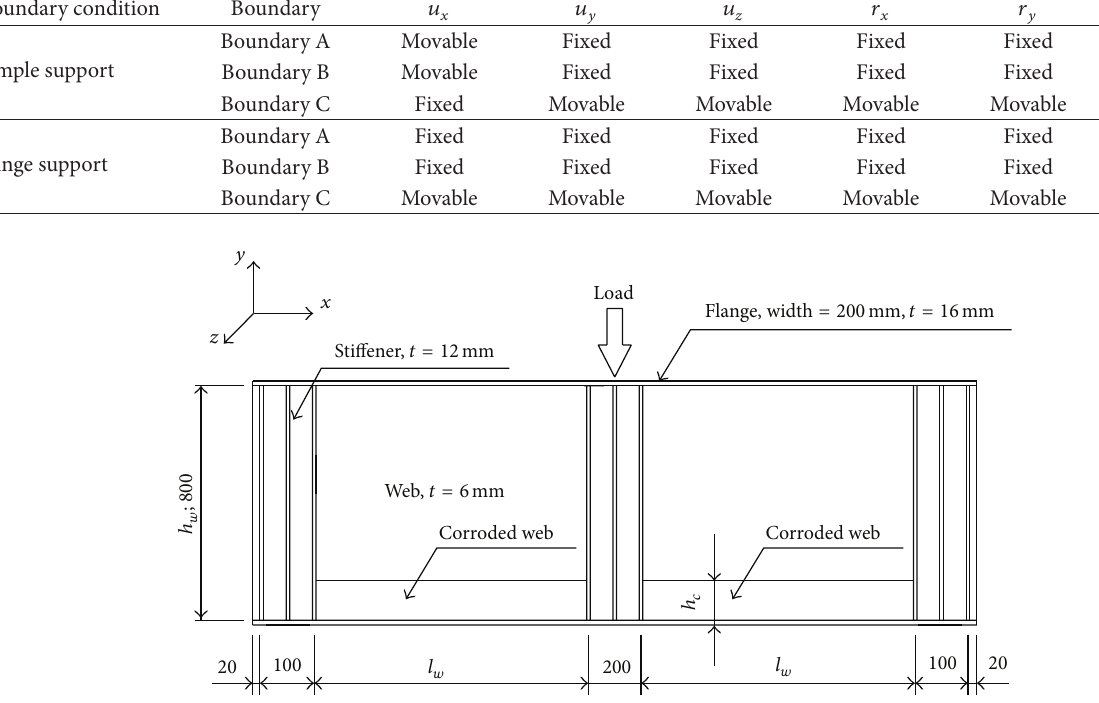
Figure 1: Dimensions of FE analysis model (unit: mm).